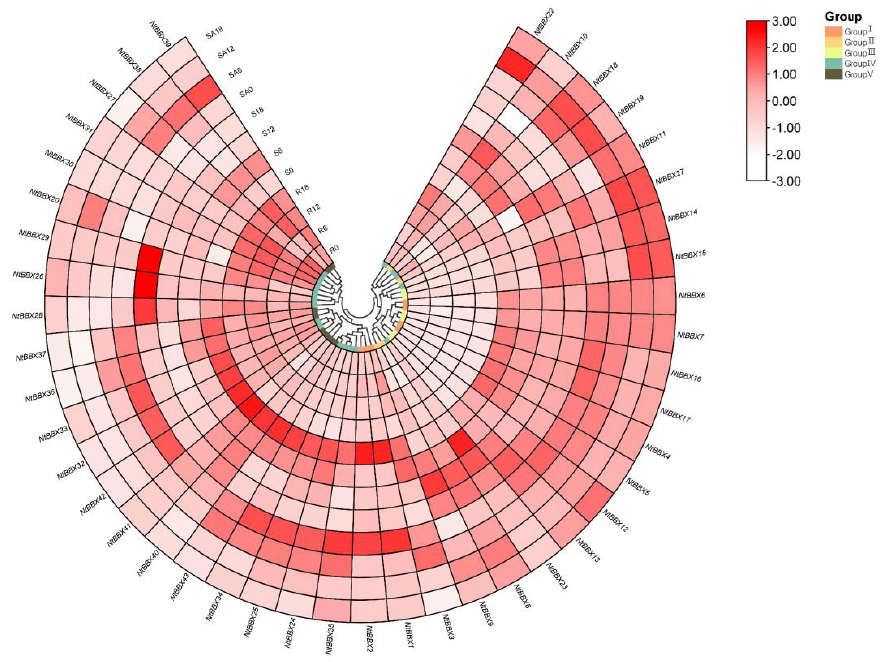
Figure 9. Expression patterns of NtBBX genes in different tissues. R, roots. S, stems. SA, stem apexes. Subgroups Ⅰ–Ⅴ are represented by different colored boxes.